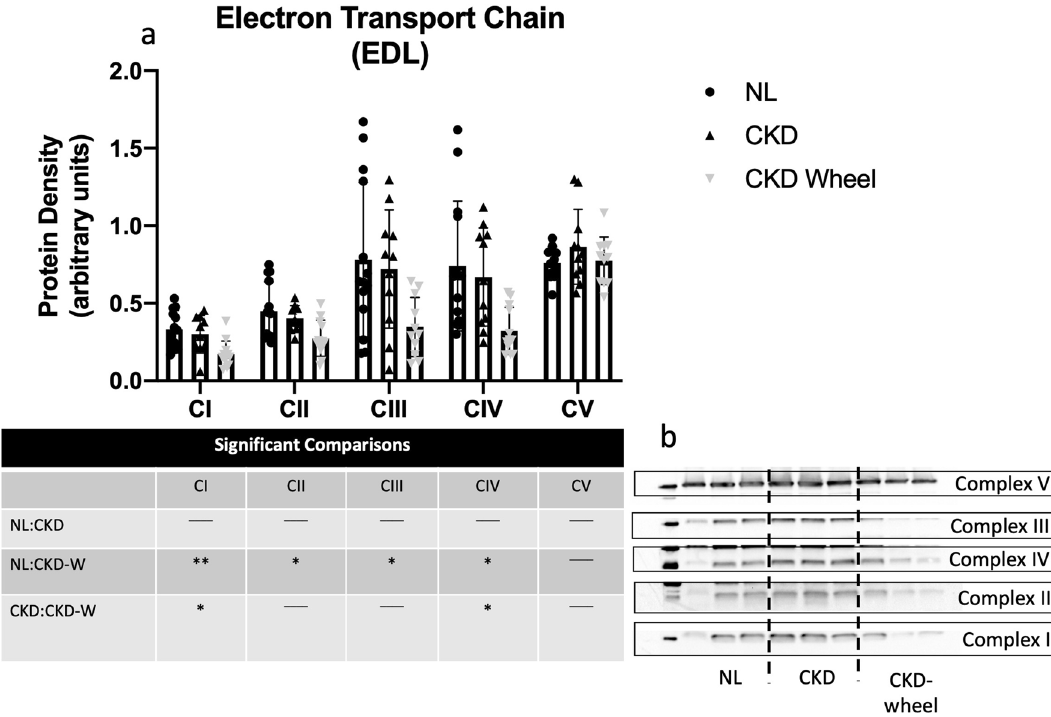
Figure 6. Mitochondrial content is decreased in the EDL of CKD wheel running rats. ( a ) The fast-twitch EDL demonstrated no differences in mitochondrial content markers between NL and CKD rats across complexes I-V subunits. However, when CKD rats performed wheel running, mitochondrial content markers were significantly lower for complex I-IV subunits when compared to NL rats. When comparing CKD to CKD-W, mitochondrial complexes I and IV subunits were lower in CKD-W. ( b ) Representative OXPHOS blots are provided with manipulated figures to unique exposures times per individual complex. Data are shown as mean ± SD (n = 9 rats each group). * p < 0.05, ** p <